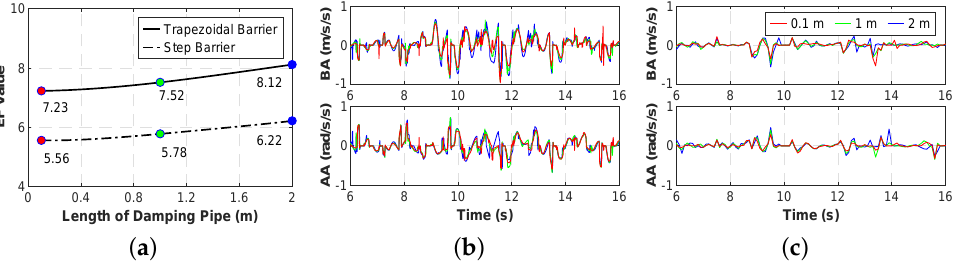
Figure 14. Performance comparison of different pipe lengths: ( a ) EF value ( b ) Acceleration values of trapezoidal barrier traversing ( c ) Acceleration values of step barrier